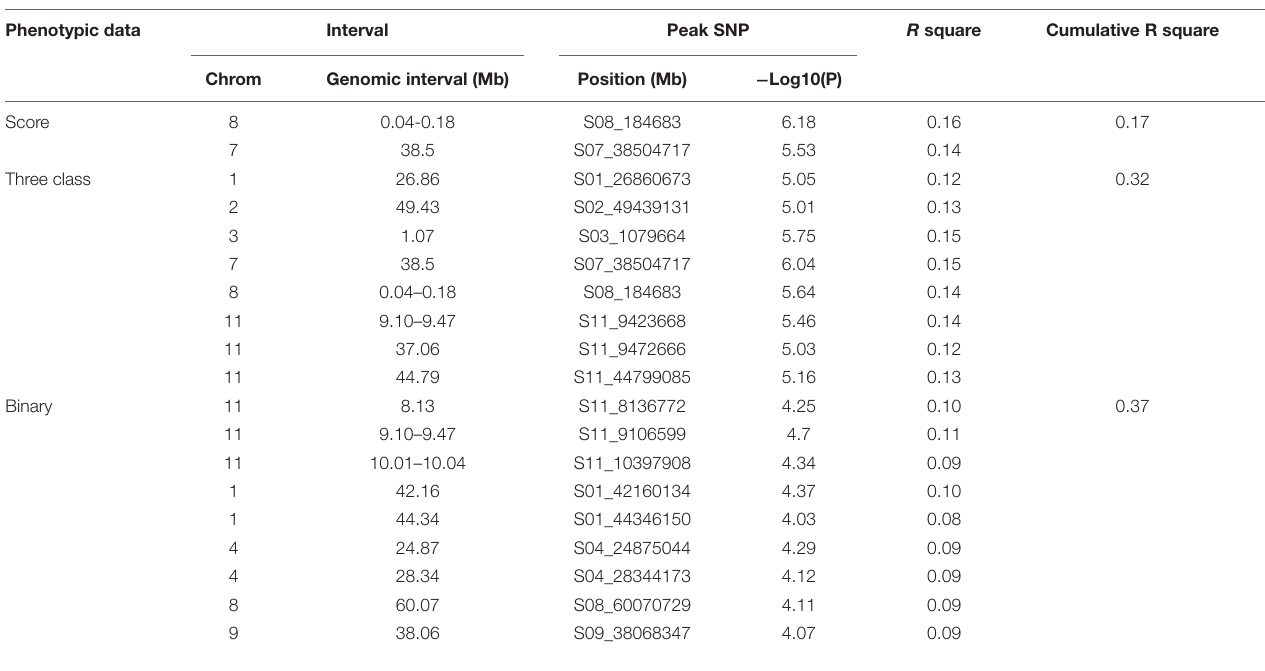
TABLE 4 | Significant genomic regions/SNPs from GWAS in Andean Diversity Panel ( P <